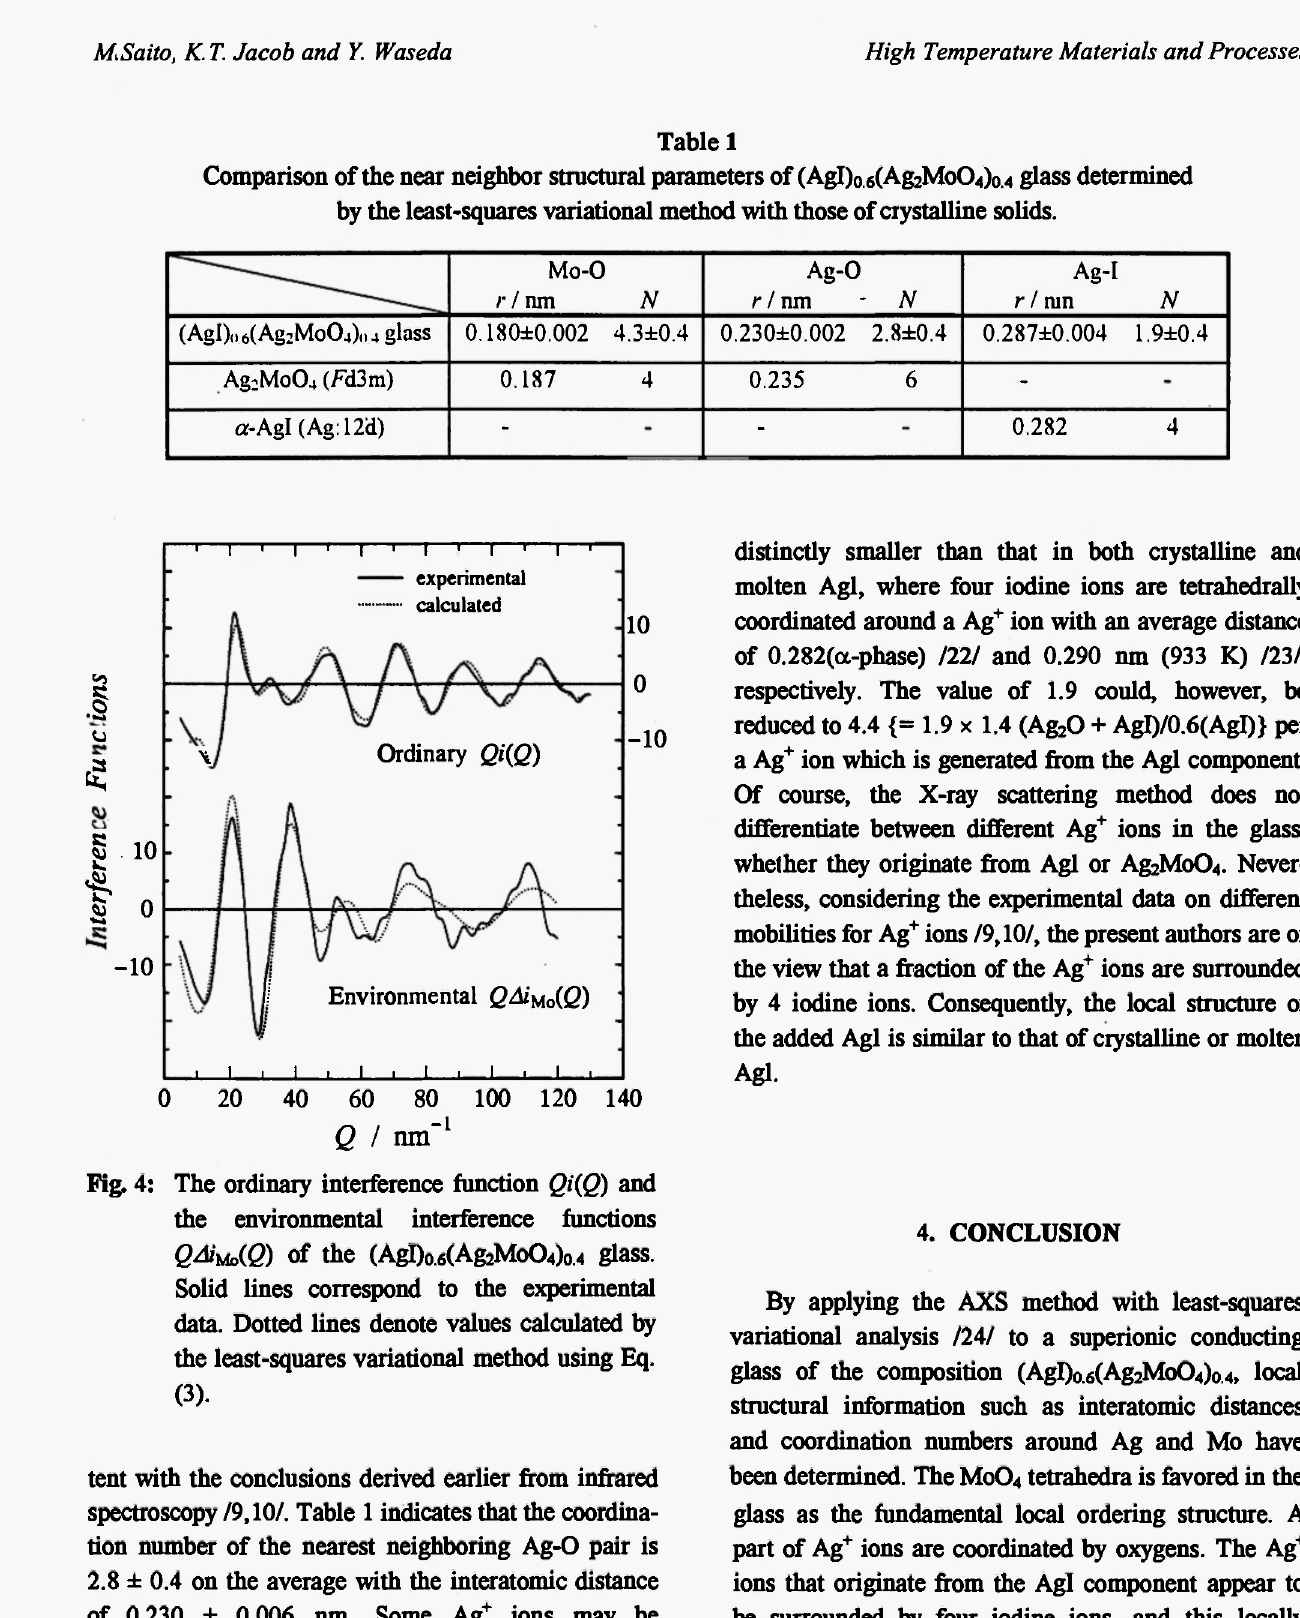
)o.4 glass determined 4